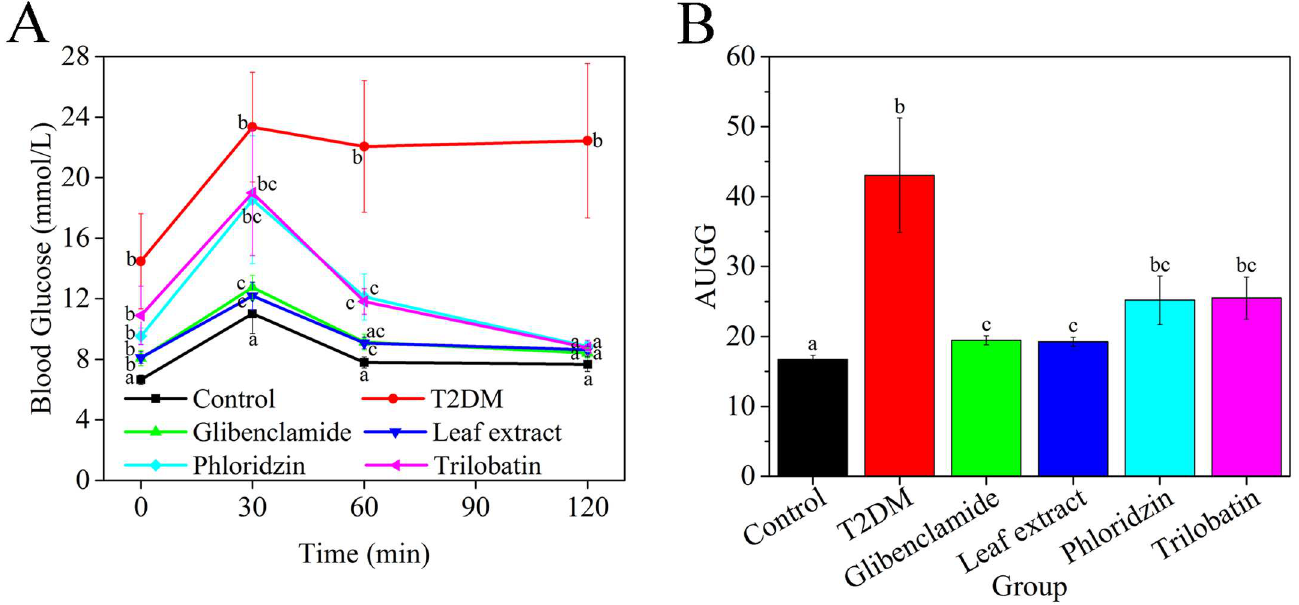
Fig 3. Effect of leaf extractsfrom L . polystachyus Rehd. on glucose tolerance. (A) OGTT tests for treatment groups after four weeks’ gavage; data taken after 12 h fast from tail at 0, 30, 60 and 120 min after glucoseloading.(B) AUCG of mean blood glucosefor all treatments. The data were analyzedwith ANOVA. All values are expressedas the mean ± SEM, n = 10. Columns labeledwith different letters are significantly different at P < 0.05.